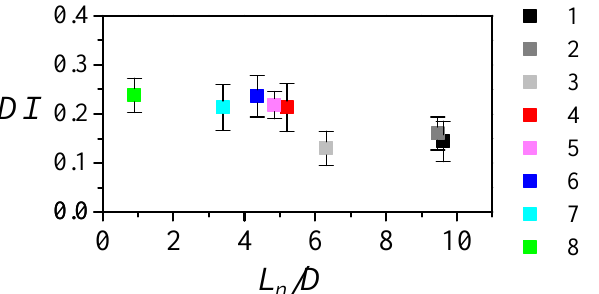
Figure 11. Particle deformation index DI measured at the neck versus the neck aspect ratio AR for the different nozzles. The symbol color indicates the nozzle number in Table 1. The flow rate was Q = 5 µ